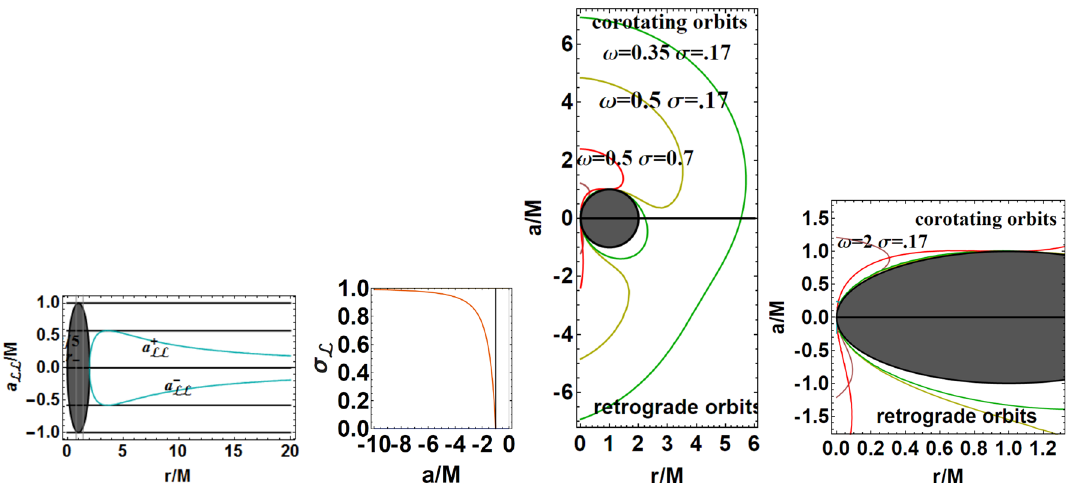
Fig. 29 Study of negative frequencies based on the analysis of Sect. B.1. Left panel: plots of spin a LL of Eq. (127) as functions of r / M . The black region is the black hole on the extended plane (i.e. a ∈ [− a ± , a ± ] ). Second panel: limiting spin σ L of Eq. (126) as func- tion of a < 0. Third panel: study of the metric bundles associated with